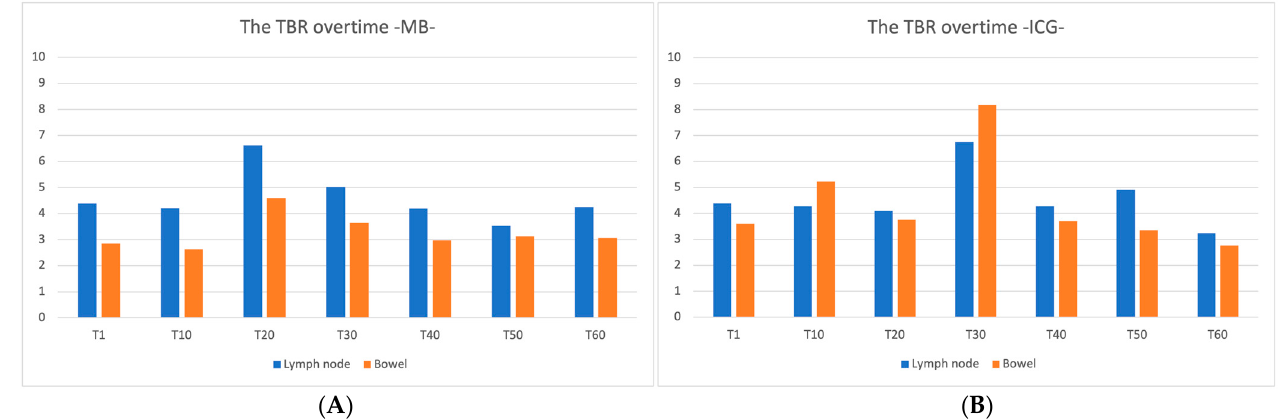
Figure 3. The TBR over time, ( A ) MB ( B ) ICG. TBR, target-to-background ratio; MB, methylene blue; ICG, indocyanine green.